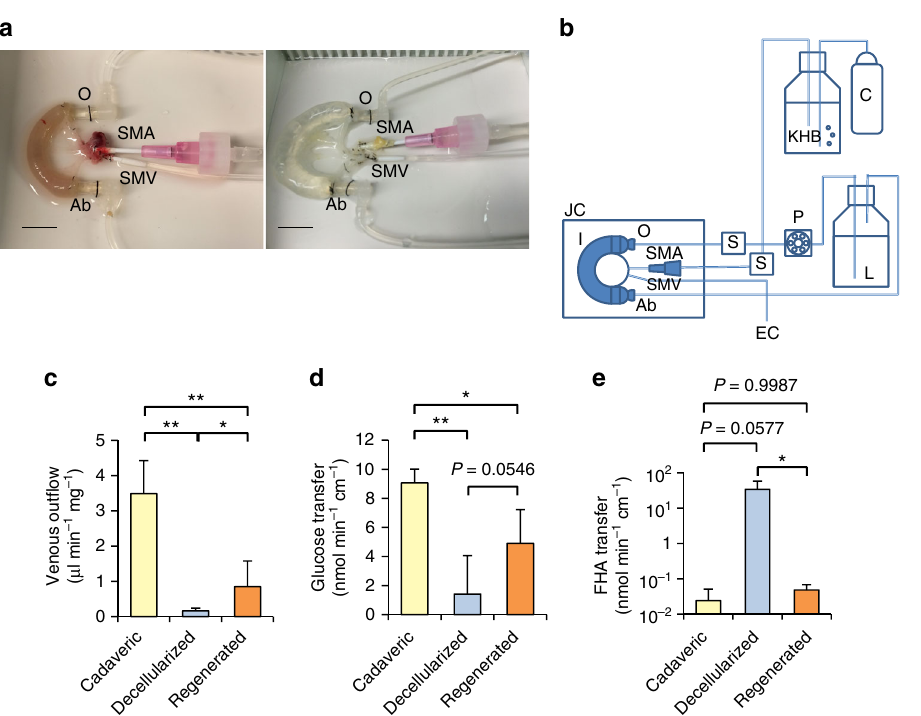
Fig. 4 Ex vivo functional assay of bioengineered intestinal grafts. a Photographs of a cadaveric and a recellularized intestinal scaffold undergoing ex vivo perfusion in a thermostatic chamber. Grafts were perfused with vascular perfusate through the cannulated superior mesenteric artery (SMA), while the intestinal lumen was instilled with luminal perfusate that contained nutritional elements. Vascular ef fl uent was collected through the cannulated superior mesenteric vein (SMV). Scale bars , 1 cm. b Diagram of the isolated perfusion circuit used for ex vivo functional analysis. Oxygenated Krebs – Heinseleit buffer (KHB) was perfused through the SMA under constant pressure of 80 mmHg, while luminal perfusate (L) was infused at a constant rate of 0.6 ml min − 1 using a peristaltic pump (P). c Flow rates of vascular perfusate measured by venous ef fl uent collection of cadaveric, decellularized, and regenerated intestines ( n = 3), showing loss of vascular fl owthrough with decellularization and partial restoration in regenerated intestines. The data were normalized by tissue mass. d Luminal-to-vascular glucose transfer rate of cadaveric, decellularized, and regenerated intestines ( n = 3), showing loss of glucose absorptive function after decellularization and nearly-signi fi cant restoration in regenerated intestines. The data were normalized by length of intestine. e Luminal-to-vascular 6-Fluorescein-5(6)-carboxamido hexanoic acid (FHA) transfer rates of cadaveric, decellularized, and regenerated intestines ( n = 3), showing increased FHA transfer in decellularized compared to cadaveric intestine, but a similar rate to cadaveric tissue in regenerated intestines. The data were normalized by length of intestine. Error bars , mean ± s.d. of experimental values. * P < 0.05; ** P < 0.01, Student ’ s t test. Ab, aboral end of the intestinal lumen; C, carbogen; EC, ef fl uent collection; JC, thermostatic jacketed chamber; O, oral end of the intestinal lumen; S, pressure